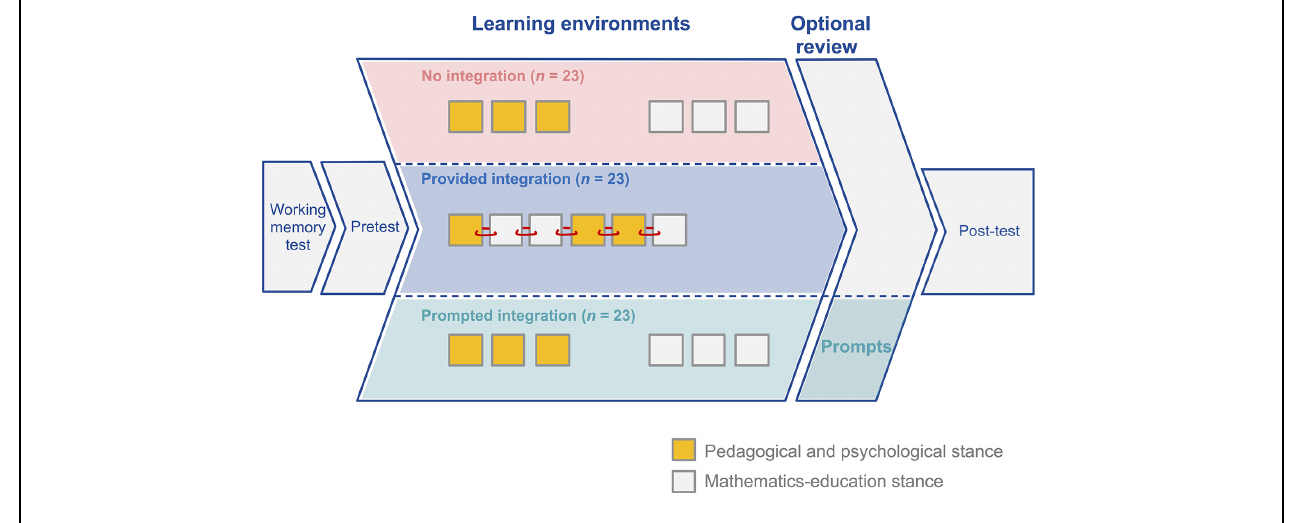
FIGURE 1 | Overview of the procedures of the three experimental conditions.